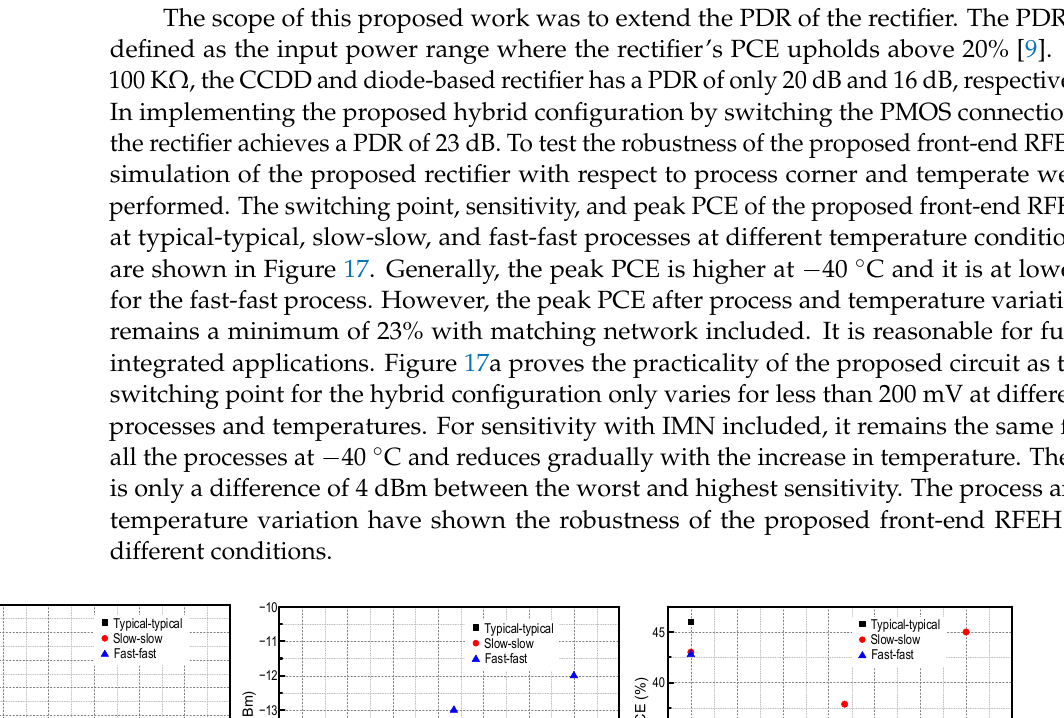
14 of 16 Figure 16. ( a ) The relationship between the input power, auxiliary rectifier’s output voltage, and the